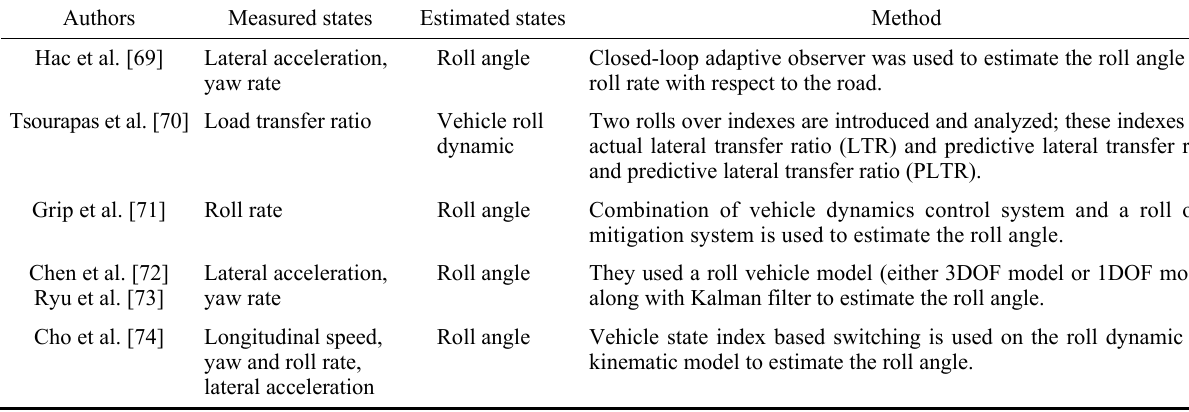
Table 2 Some of the studies which have used roll dynamic model.